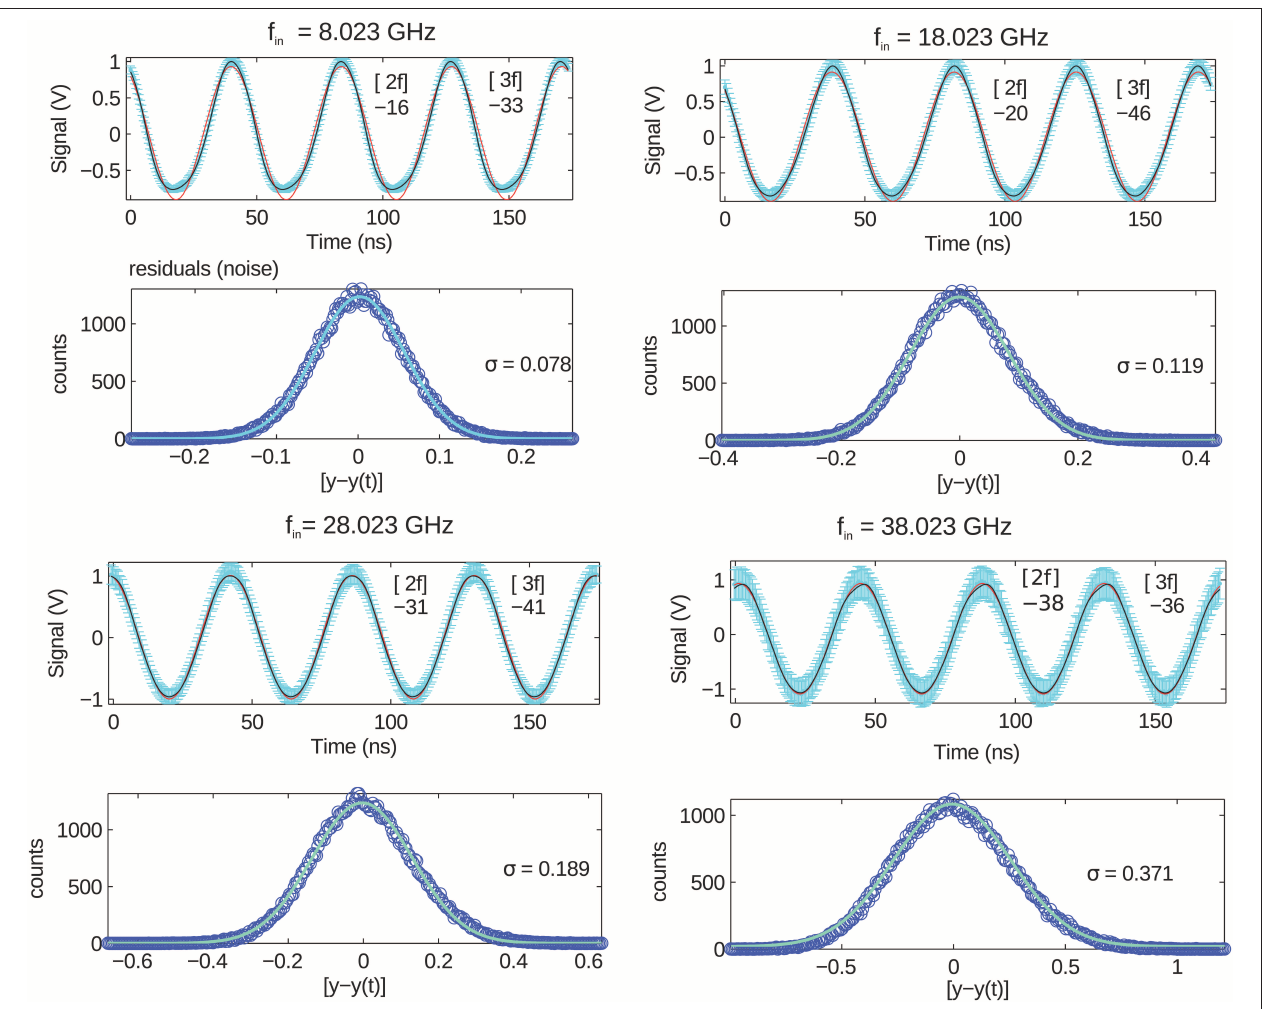
FIGURE 10 | Reconstruction of the sampled baseband signal, for initial signal frequencies f in of 8.023, 18.023, 28.023, and 38.023 GHz. For each of the four frequencies, the upper graph represents the measured samples (blue points), the fitting harmonic function of the samples (black line), and the expected ideal sinusoid (red line). [2f] and [3f] values represent the obtained second and third order harmonic distortion, expressed in dB compared to the first harmonic. The lower graph shows the Gaussian distribution of the residual error, with the fitted width σ